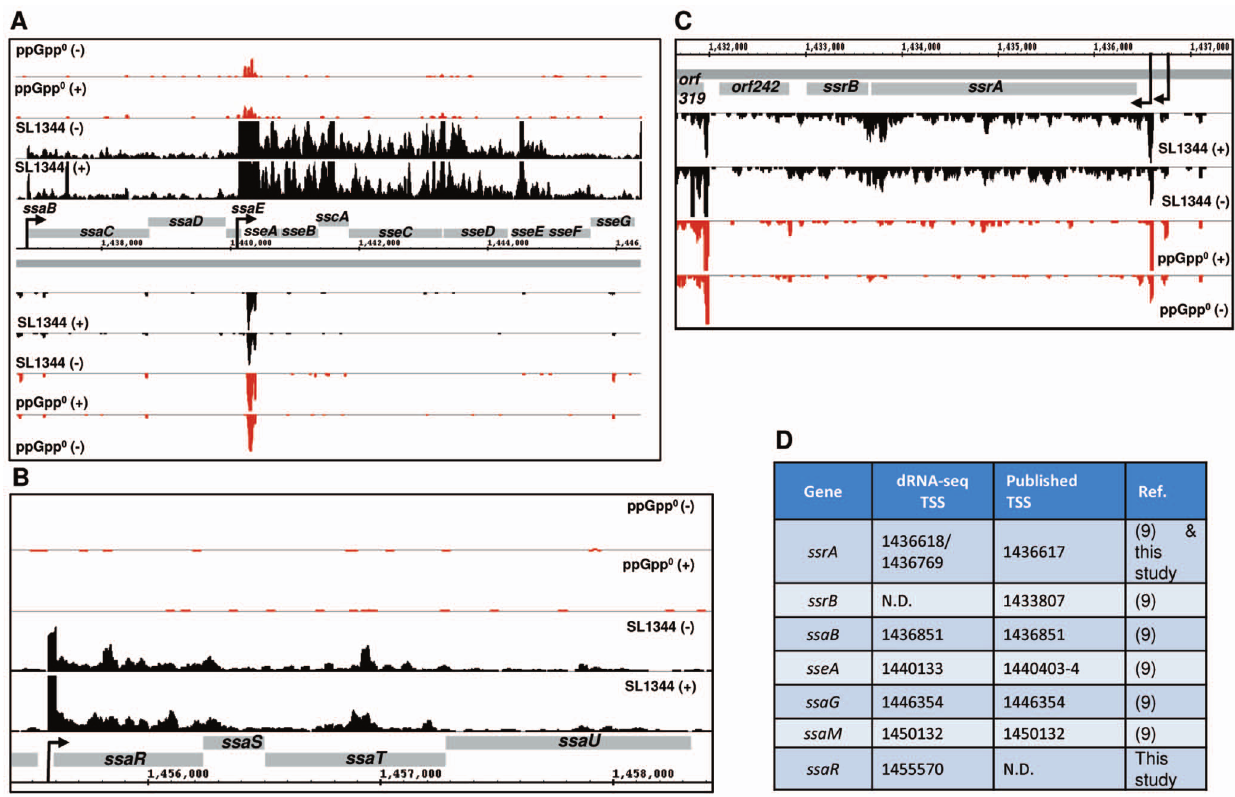
Figure 3. Promoter architecture and ppGpp-dependency of SPI2. Enriched ( + ) and non-enriched ( 2 ) cDNAs of S . Typhimurium SL1344 parent (black) or ppGpp 0 ( D relA D spoT ) (red) strains mapped onto selected regions of the SPI2 locus. Operons are indicated by horizontal arrows and annotated according to the first gene. Transcript start sites are indicated by black arrows (A) Map of ssaB and sseA operons. The Y axis in each lane represents 0–50 mapped reads per genome position. (B) Map of ssaR operon. The Y axis in each lane represents 0–150 reads. (C) Map of the ssrA operon showing transcriptional read through into ssrB and orf242 . Y axis in each lane represents 0–30 reads. (D) Location of transcript start sites identified previously and in this study; N.D. = not determined.